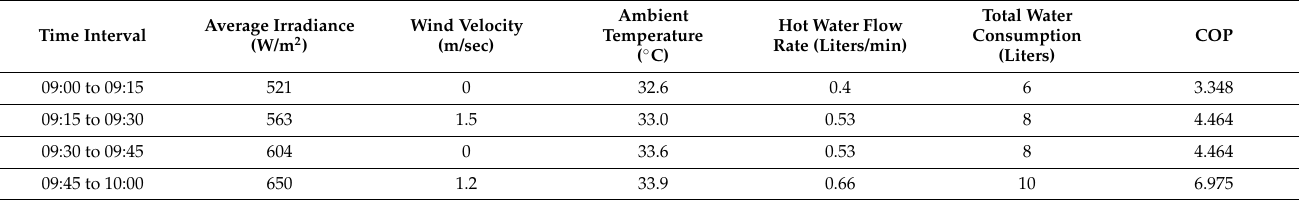
Table 6. Total water consumption—32 L (Electricity consumption—0.3 kWh).